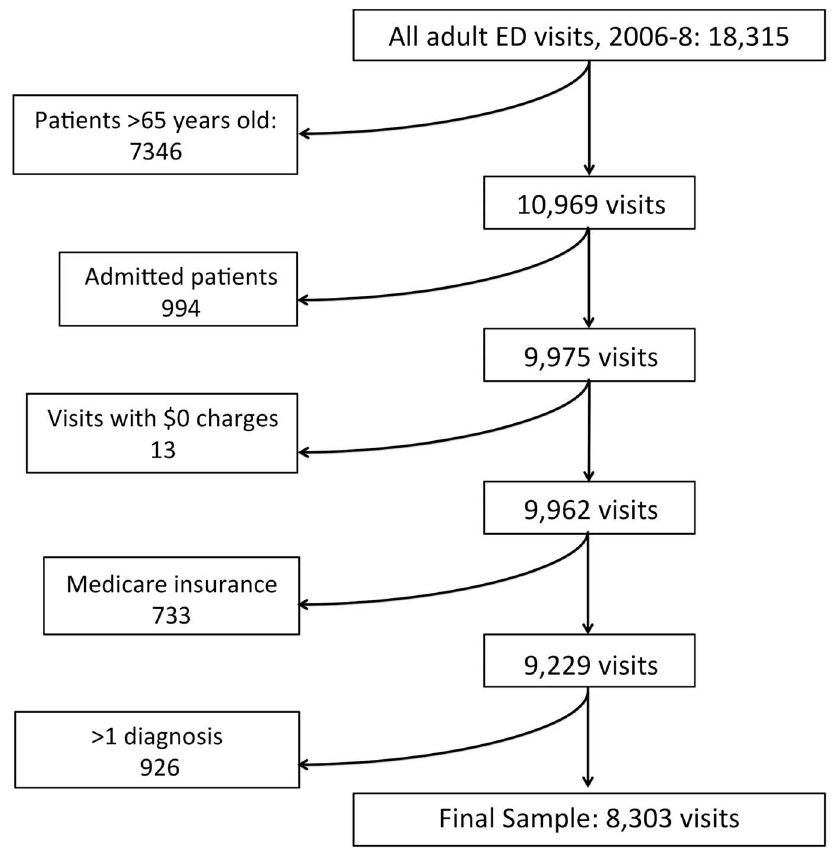
Figure 1. Sample selection process.